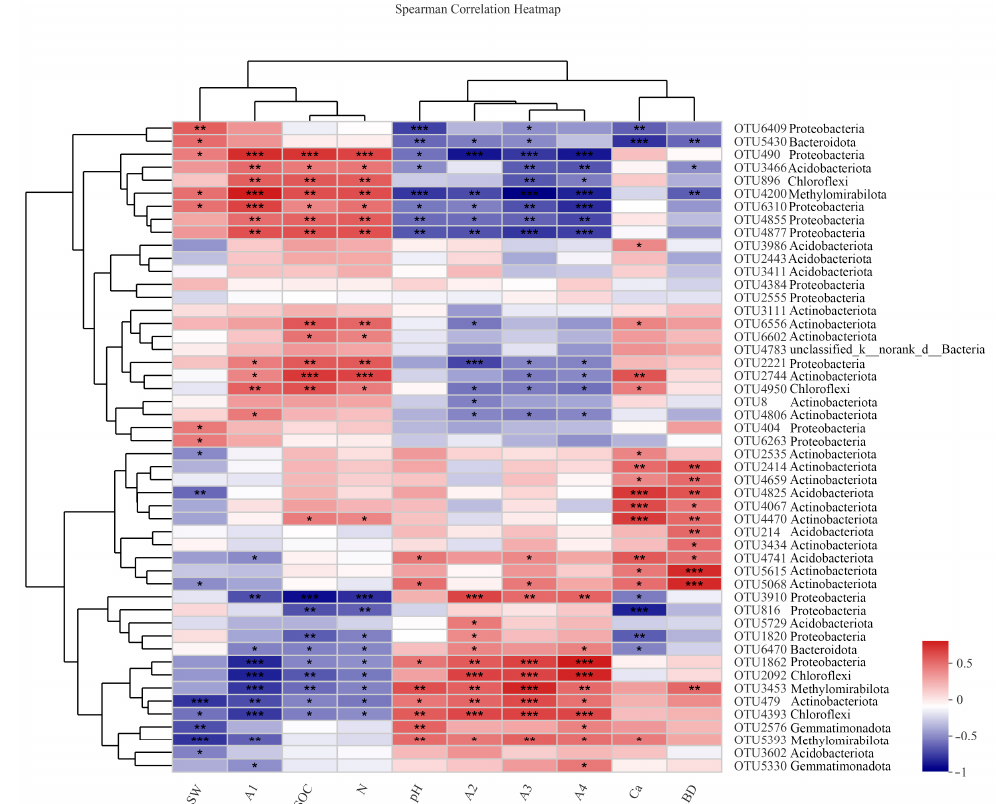
Figure 6. Spearman’s correlation cluster heatmap of the soil aggregates and soil properties with respect to the top 50 bacterial OTUs. SOC—soil organic carbon; N—nitrogen; SW—soil water; BD—bulk density; LMA—large macroaggregates; SMA—small macroaggregates;MI—microaggregates; SC—silt + clay fractions. Significance levels are denoted as follows: p < 0.05 (*), p < 0.01 (**) and p < 0.001 (***).